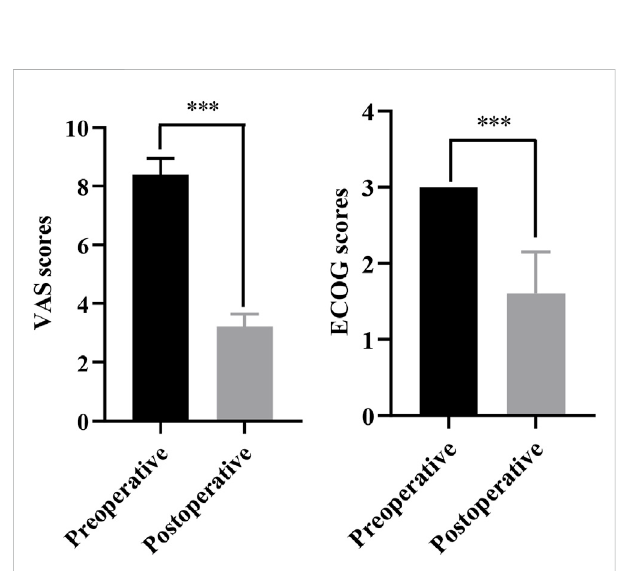
FIGURE 3 The comparison of VAS scores and ECOG scores between preoperative and postoperative. *** p <